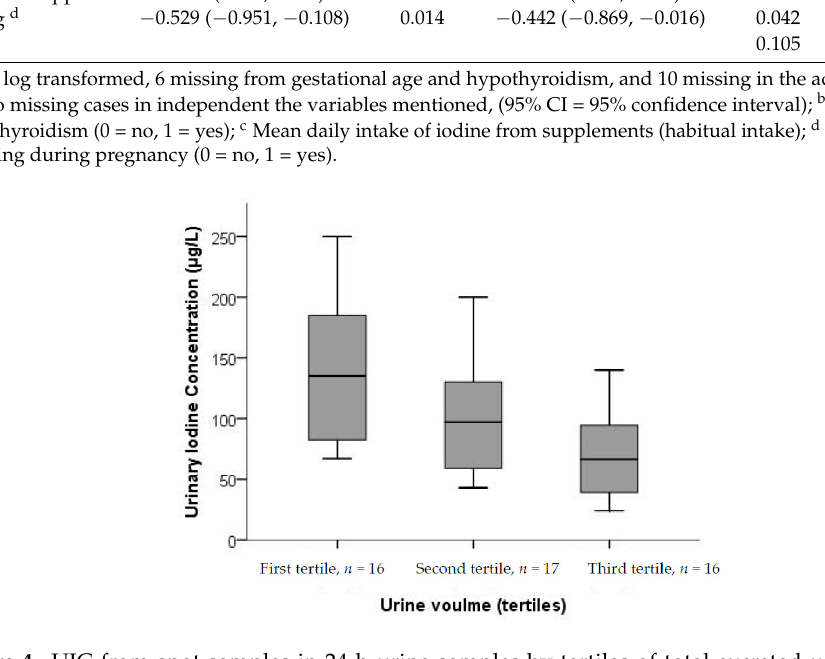
Figure 4. UIC from spot samples in 24-h urine samples by tertiles of total excreted urine volume ( n = 49). There were significant differences in UIC between the tertiles ( p = 0.002; Kruskal–Wallis test).